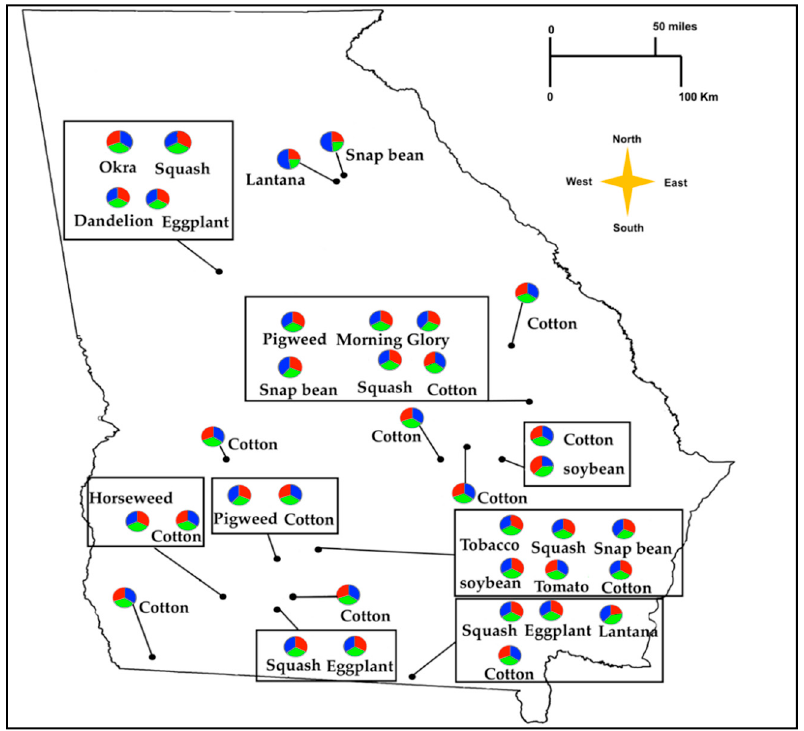
Figure 4. Pie charts showing the proportion of alleles that were inherited from a postulated ancestral population to individuals of 35 B. tabaci MEAM1 populations collected from Georgia, USA, using Bayesian clustering implemented in STRUCTURE 2.3.4 at K = 3.